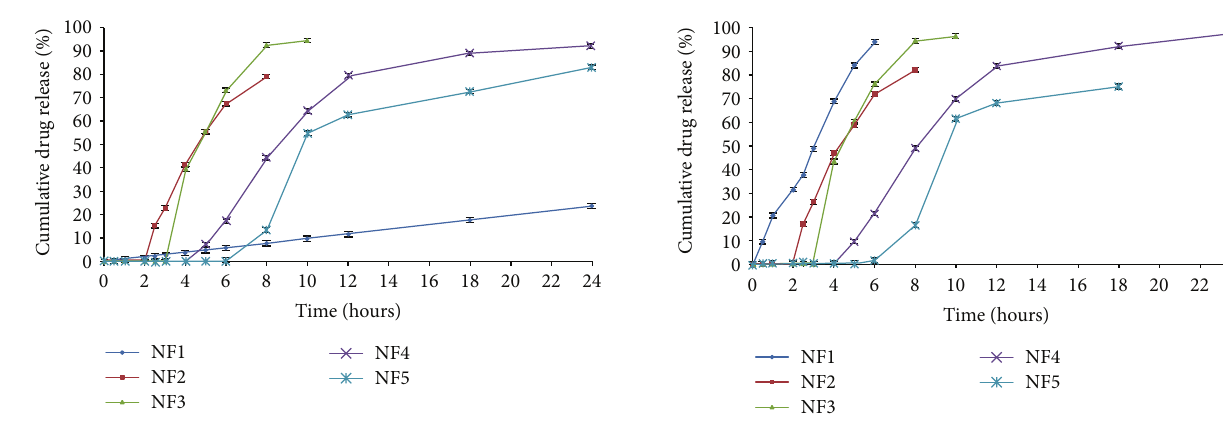
Figure 6: In vitro release profiles of various formulations of naproxen sodium (NF1, NF2, NF3, NF4, and NF5) in presence of 4% w/v rat caecal content. Data are expressed as mean ± S.D. ( 𝑛 = 3